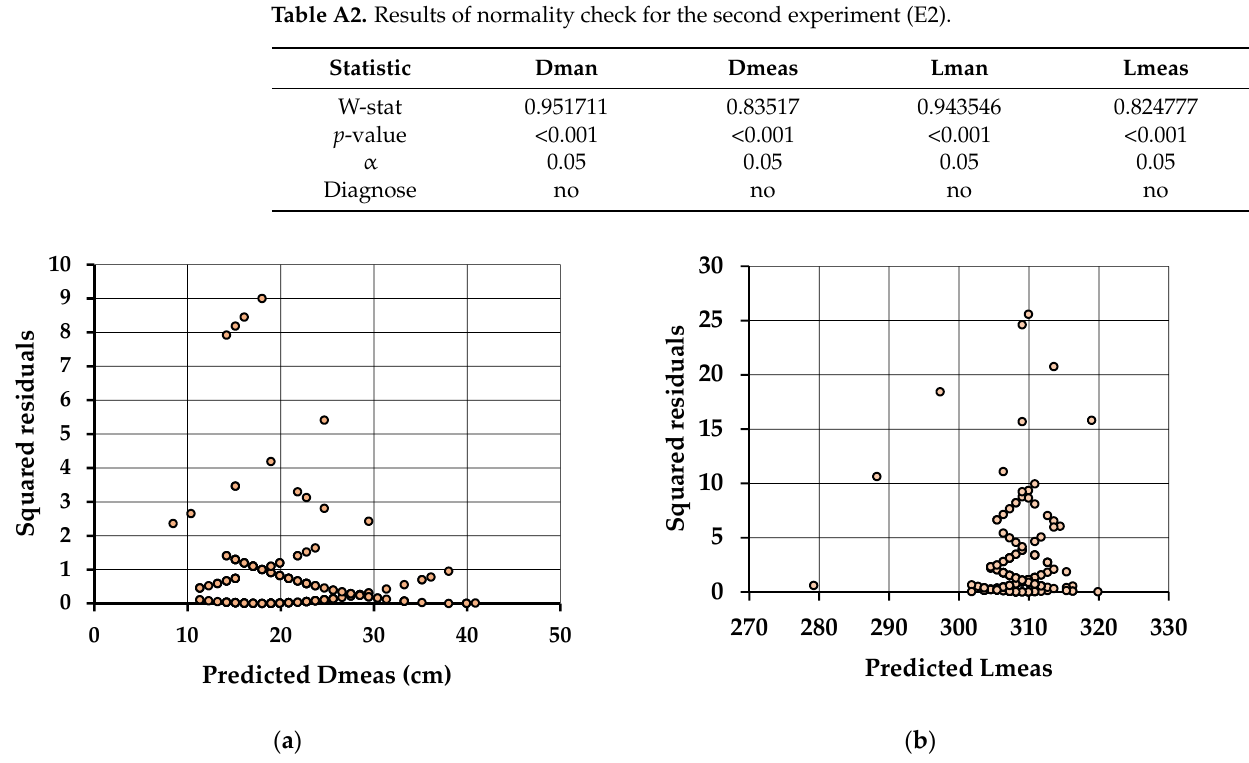
Figure A2. Results of the test for homoskedasticity (E2): ( a ) Plot of squared residuals against the predicted Dmeas (Note: data was homoskedastic by Breusch-Pagan test, p > 0.05); ( b ) Plot of squared residuals against the predicted Lmeas (Note: data was homoskedastic by Breusch-Pagan test, p > 0.05).